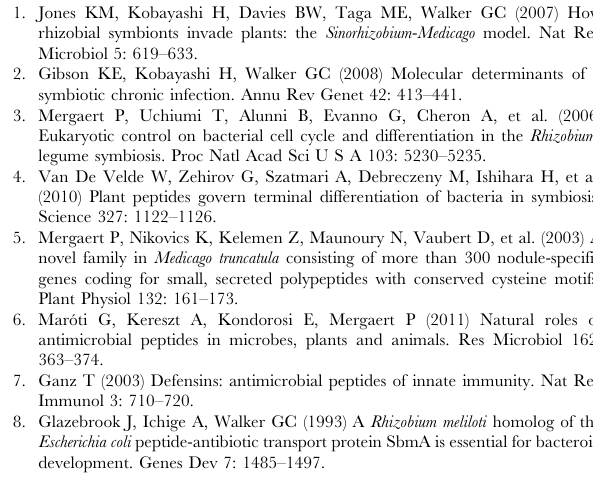
Figure S7 The S. meliloti BacA-deficient mutant undergoes rapid death in symbiosomes. Confocal microscopy of either the S. meliloti